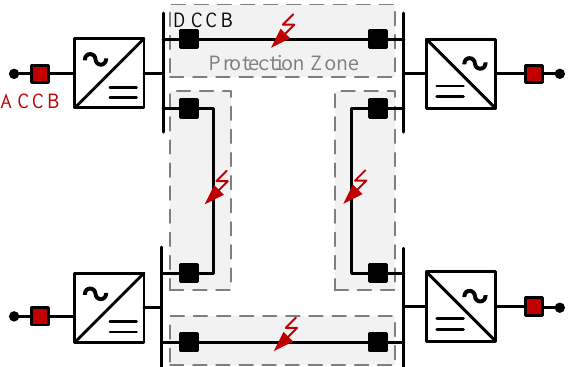
Figure 5. Line protection zones with a fully-selective fault clearing strategy. A compromised solution is the partially-selective fault clearing strategy or the grid- splitting strategy, where the entire grid is divided into two or more protection zones, called subgrids, separated by interface DCCBs or DC/DC converters, as shown in Figure 6. A fault within a subgrid results in its tripping via the interfacing equipment and ACCBs of the faulted subgrid. Then, HSSs open to isolate the faulted segment, similar to the non-selective philosophy, resulting in the rapid restoration of the healthy part of the isolated subgrid.